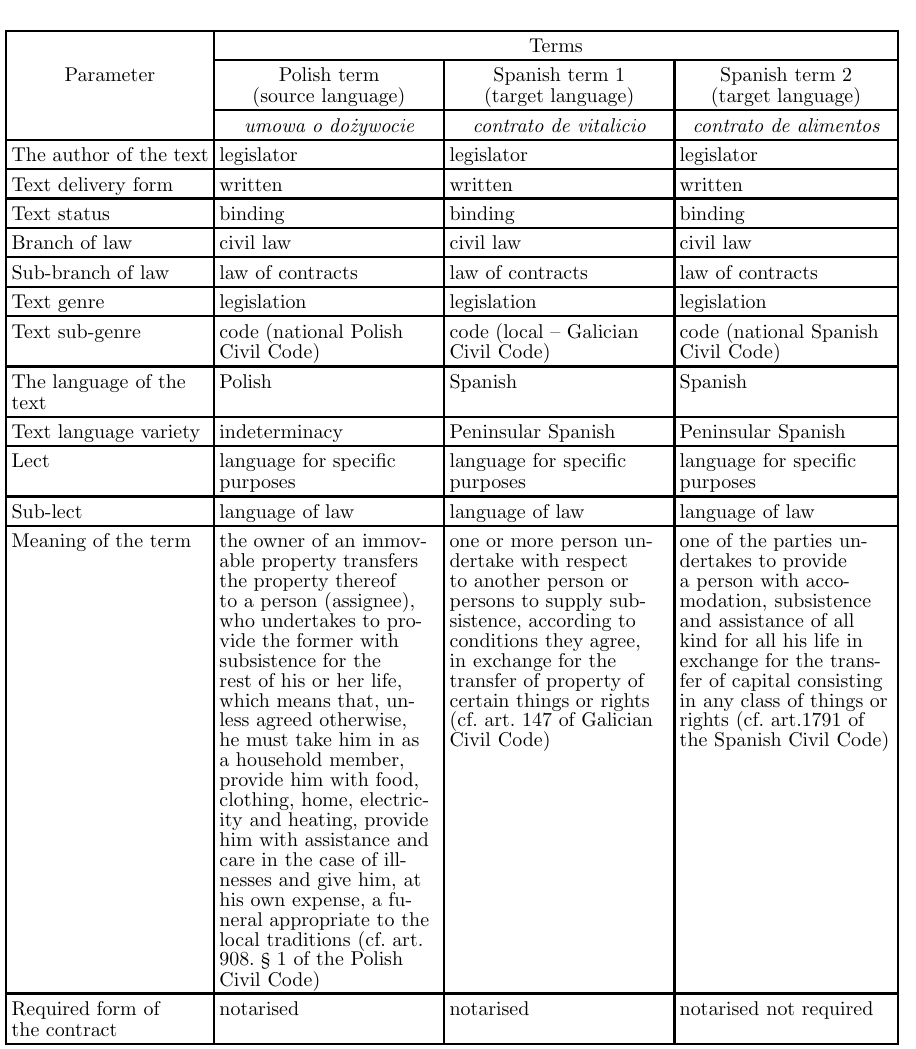
Table 2 Parametric characterisations of the Polish term umowa o dożywocie and the Spanish terms contrato de vitalicio